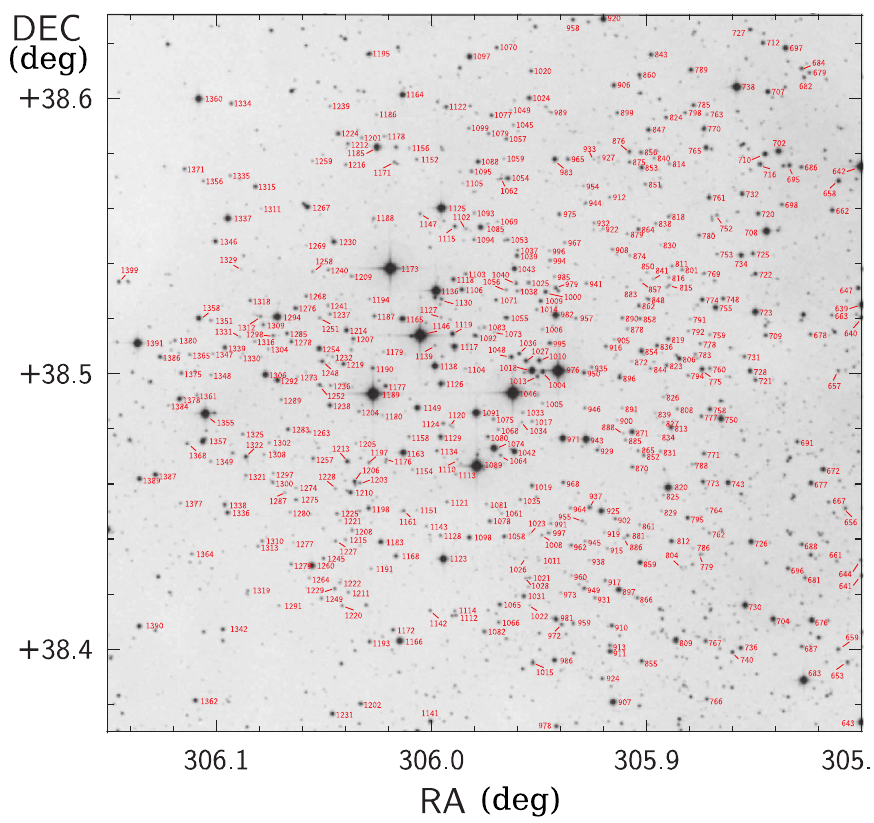
Fig. 2. Identification chart of Table 2 stars in the central area of 22 ′ (cid:2) 22 ′ size covered by the Flagstaff and VATT observations. Star numbers are written on the SkyView DSS2 Red